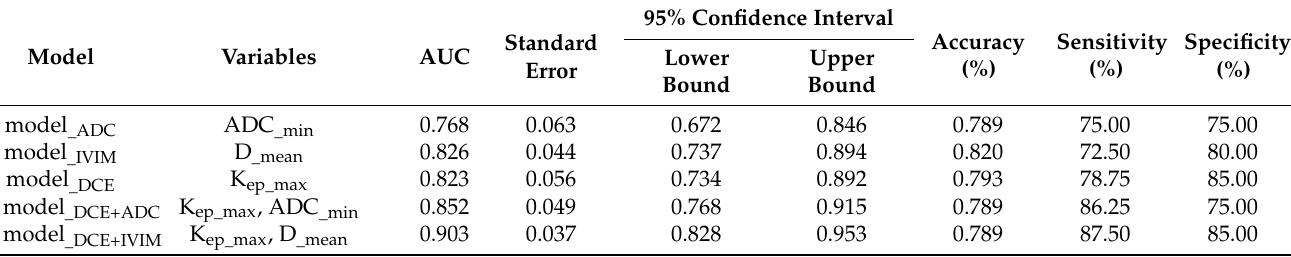
Table 4. Diagnostic performance of the